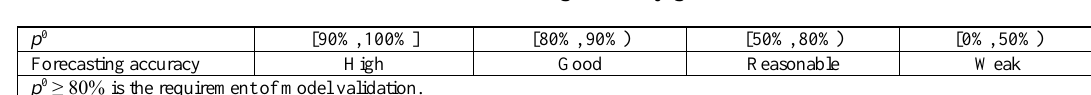
Table 1. The forecasting accuracy grade table.